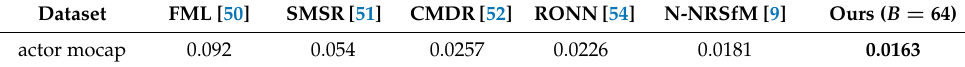
Table 3. e 3 D on the the actor